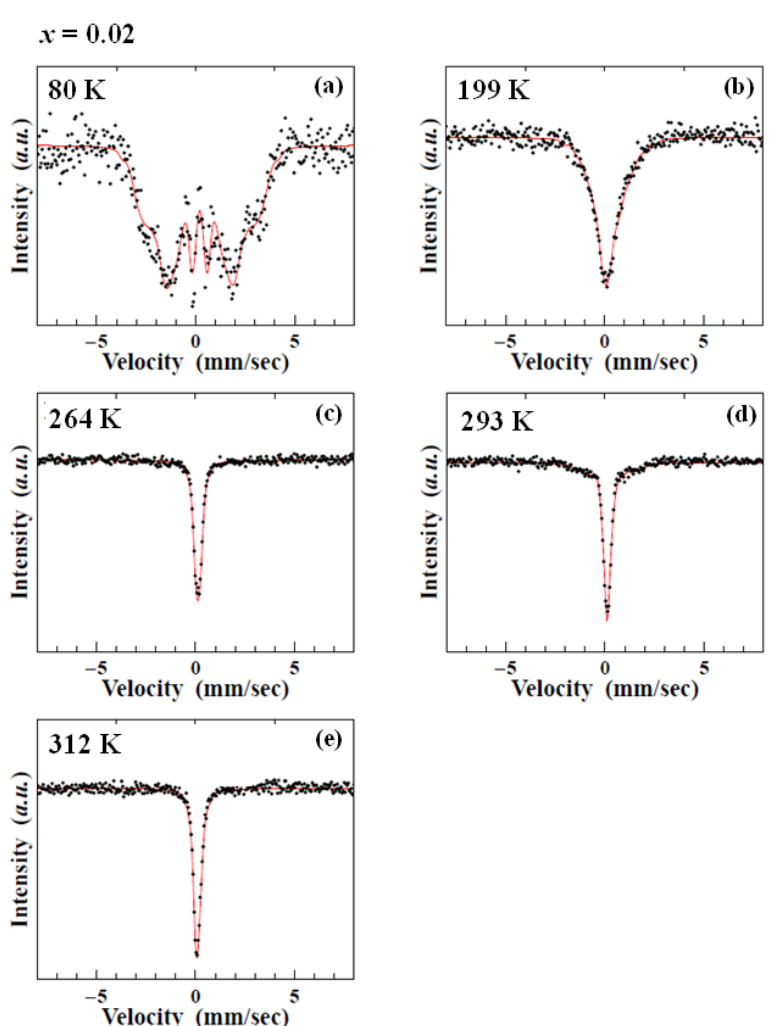
Figure 3. 57 Fe Mössbauer spectra and their fitting curves for x =